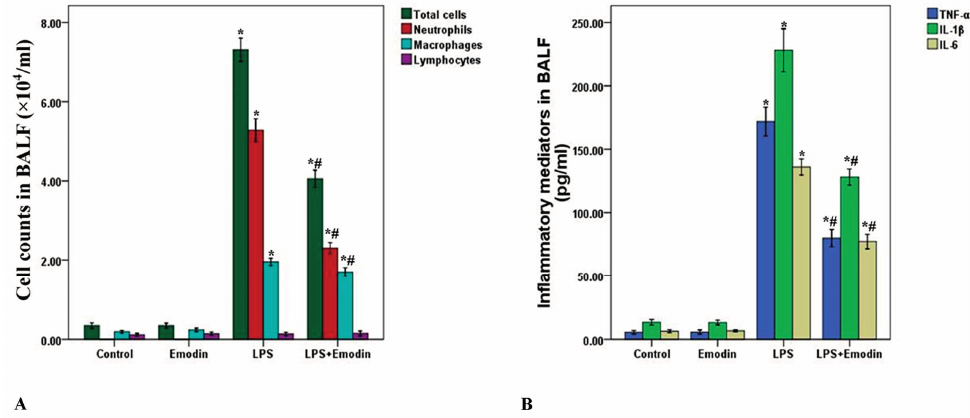
Figure 2. Emodin decreases cell counts and inflammatory mediators in bronchoalveolar lavage fluid (BALF) in LPS-induced ALI. Three days after interventions, mice were sacrificed and their lungs were lavaged. ( A ) Cells in BALF were collected and cytospin preparations were made. Total cells, neutrophils, macrophages and lymphocytes in BALF were measured; ( B ) TNF- α , IL-6 and IL-1 β in BALF were analyzed by ELISA. Each bar represents the mean ± SD of 10 mice. * p < 0.05 compared with Control. # p < 0.05 compared with